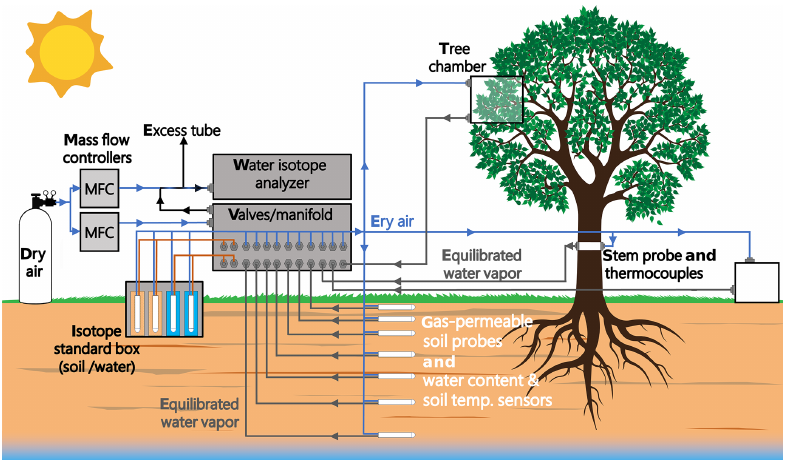
Figure 7. An idealized, yet complicated, in situ system depicting all relevant components for a complete measurement of water isotopes of soils (depth-dependent and bulk soil) and plants (in tree xylem and at the leaf